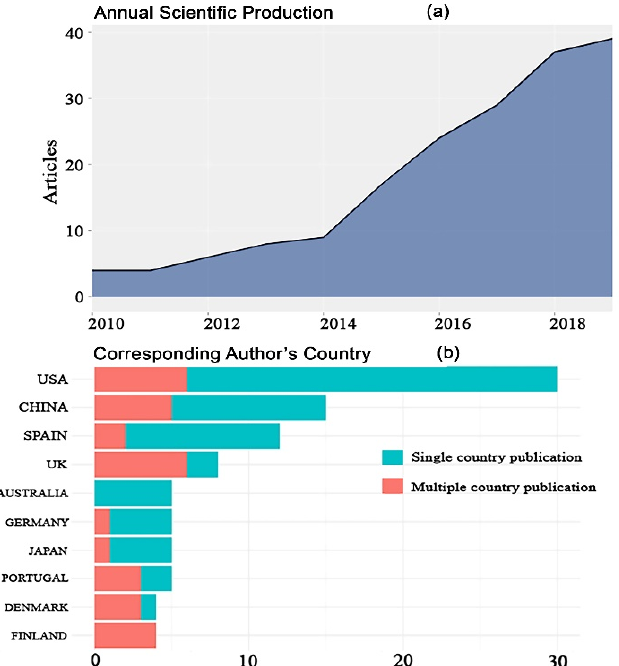
Figure 2. Bibliometric analyses of UGS and social media research: ( a ) Annual scientific production, ( b ) Corresponding author’s country.